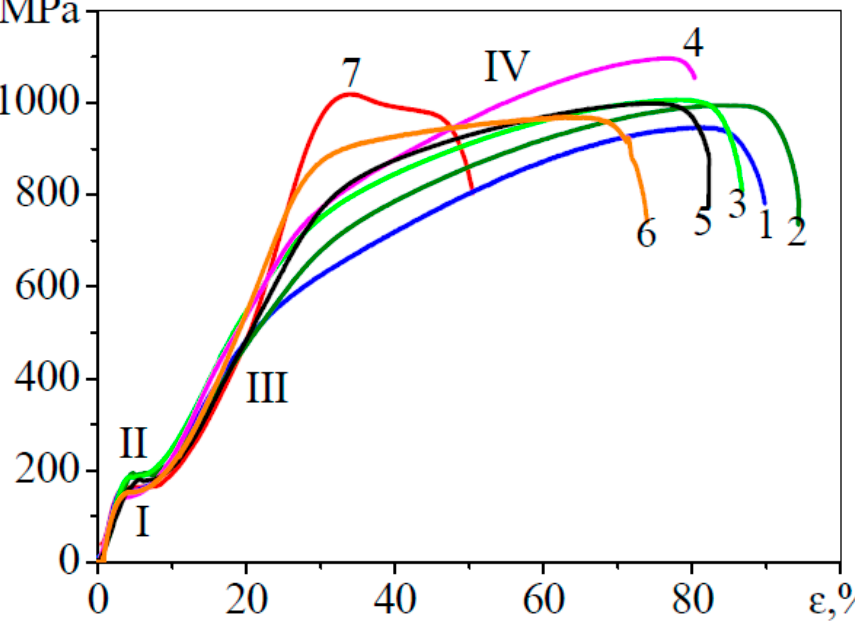
Figure 4. Engineering tensile stress–strain curves of Ti 49.8 Ni 50.2 before abc pressing ( 1 ) and after abc pressing to e = 0.29 ( 2 ), 0.62 ( 3 ), 1.82 ( 4 ), 4.15 ( 5 ), 6.44 ( 6 ), and 8.44 ( 7 ).